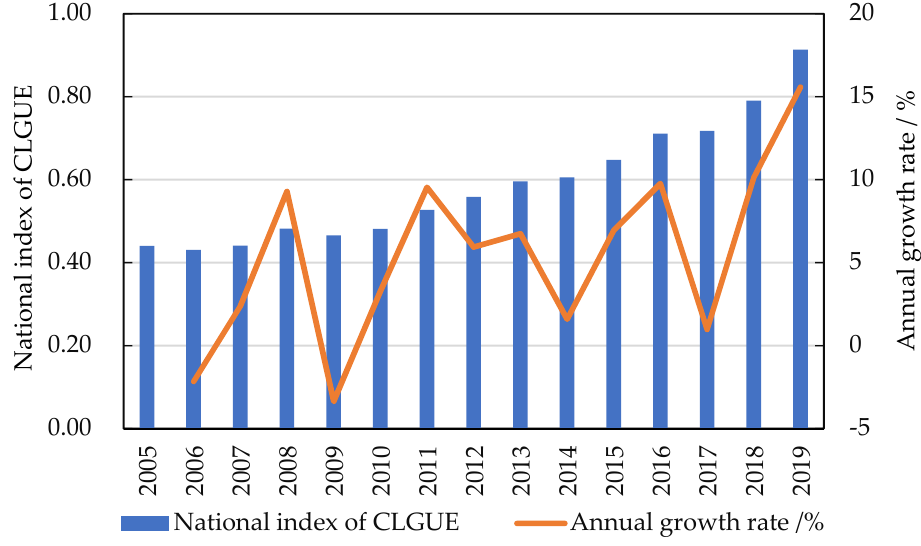
Figure 2. The average index and yearly growth rate of CLGUE in China.